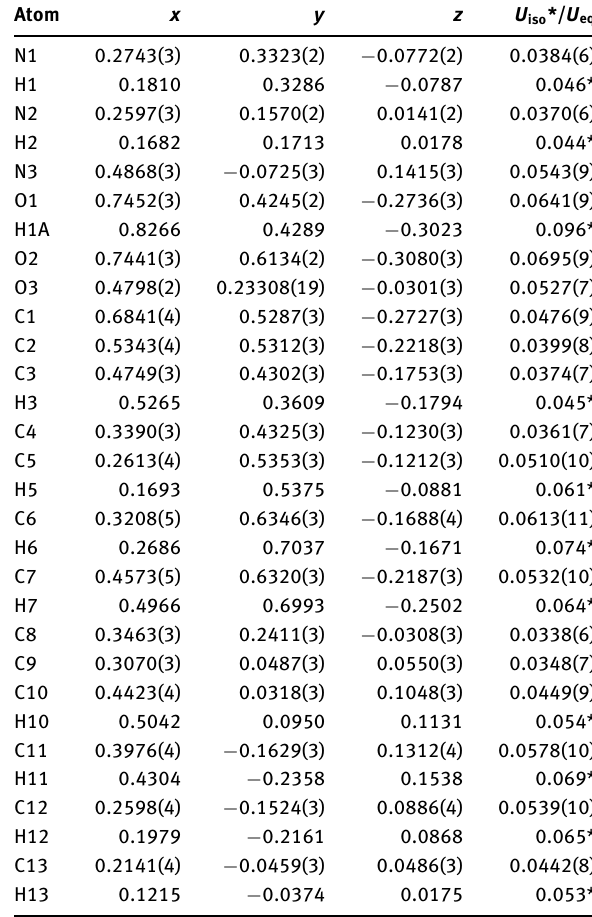
Table 2: Fractional atomic coordinates and isotropic or equivalent isotropic displacement parameters (Å 2